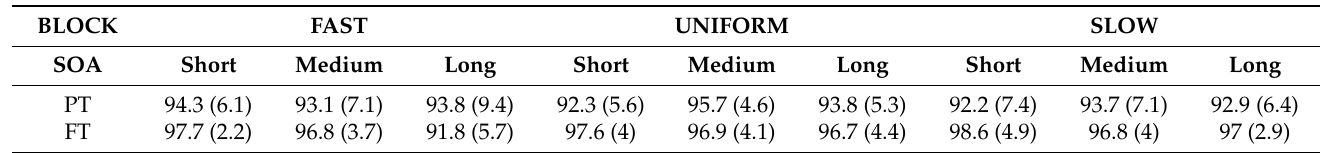
Table 2. Accuracy Mean and standard deviation (in parentheses) measures of accuracy (percentage of premature responses) for preterm (PT) and full-term (FT) children for each experimental condition.